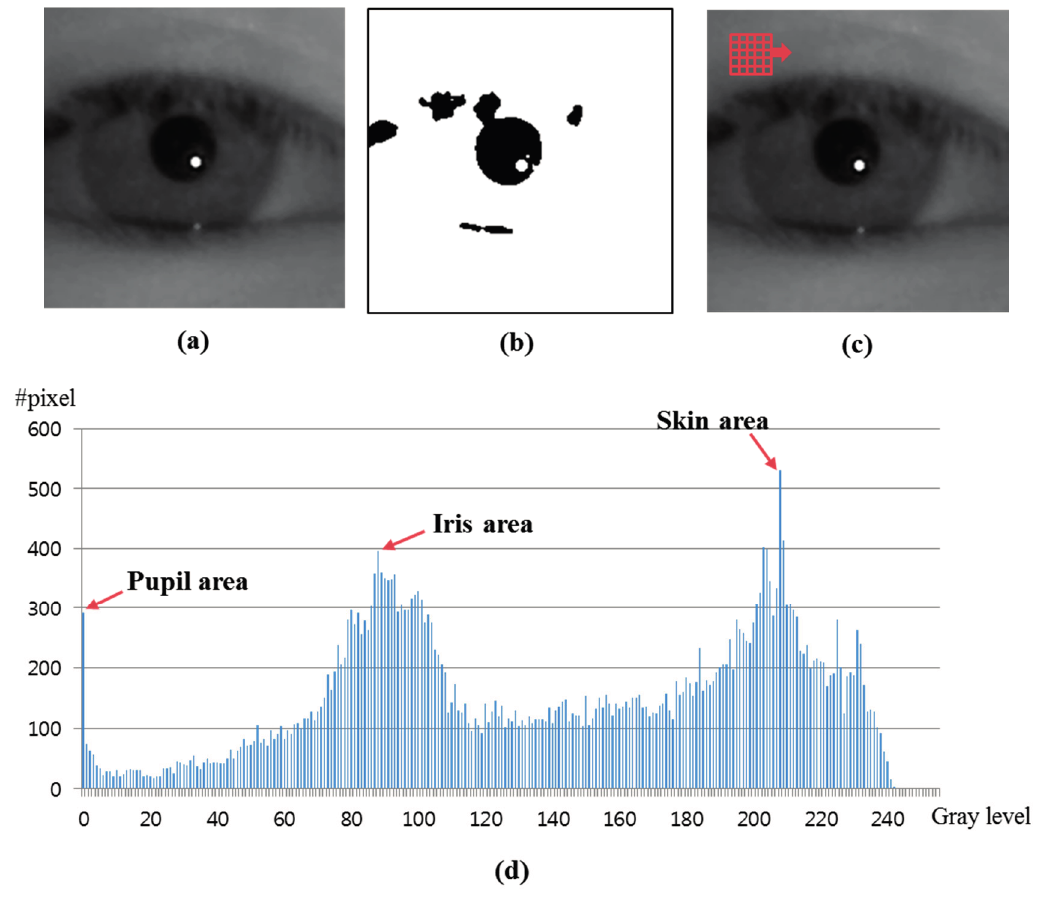
Figure 7. Binarized image using a static threshold and the eye region using the average filter. ( a ) original eye region; ( b ) binarized image using a static threshold; ( c ) result image obtained by the average filter; ( d ) histogram of